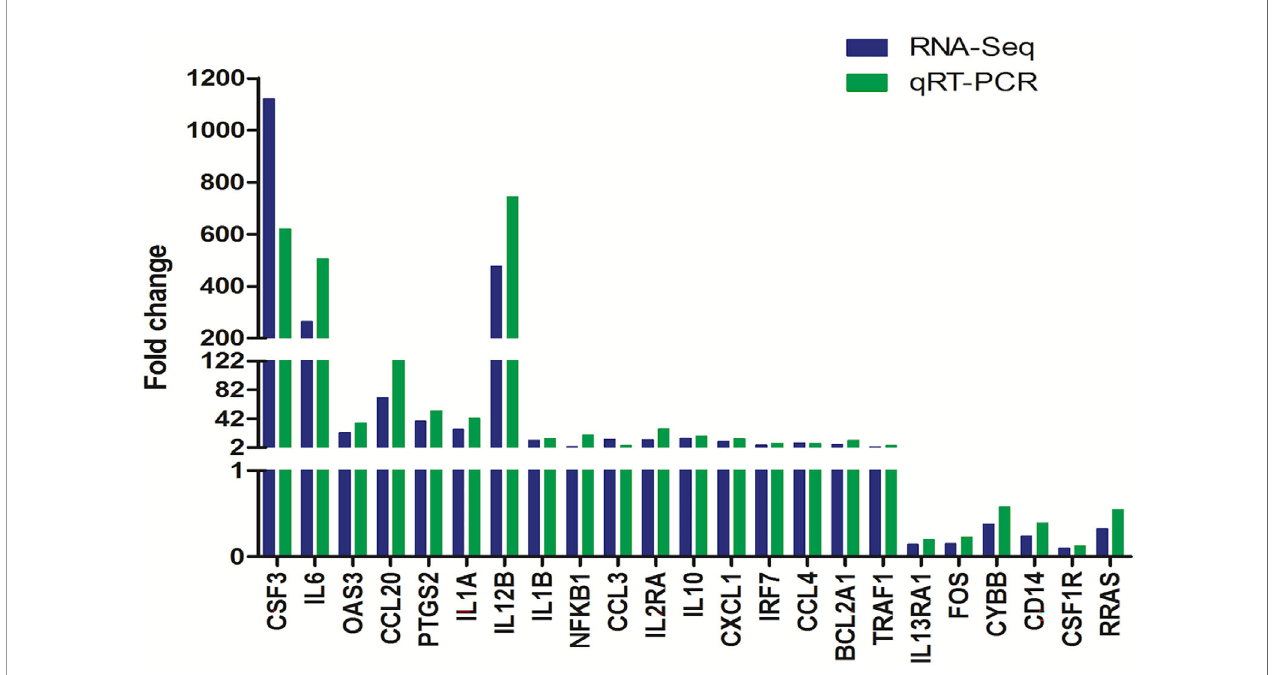
FIGURE 6 | Validation of transcriptomic sequencing results by real-time